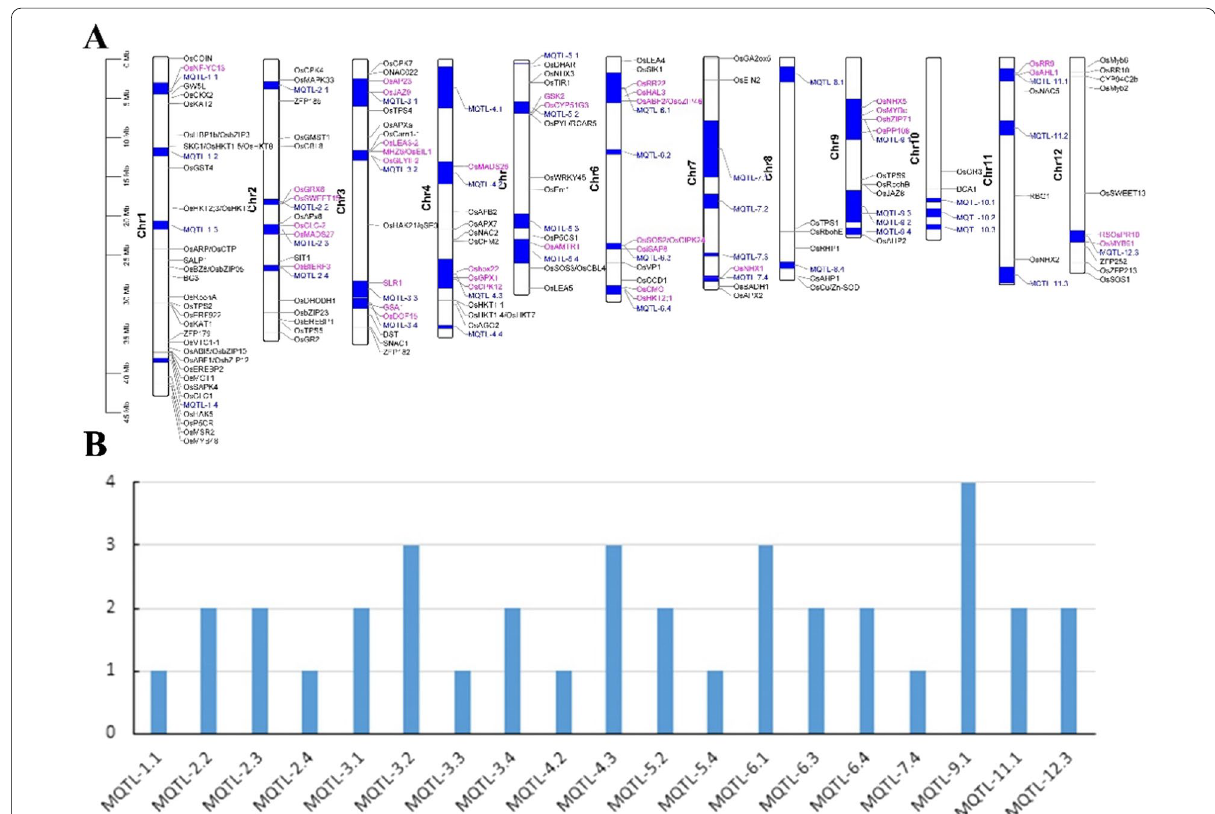
Fig. 5 Known genes into Meta-QTLs. A Distribution of known genes and Meta-QTLs on 12 chromosomes; B The number of known genes in Meta-QTLs. Note Blue represents Meta-QTLs, and red represents genes that fall into Meta-QTLs in A